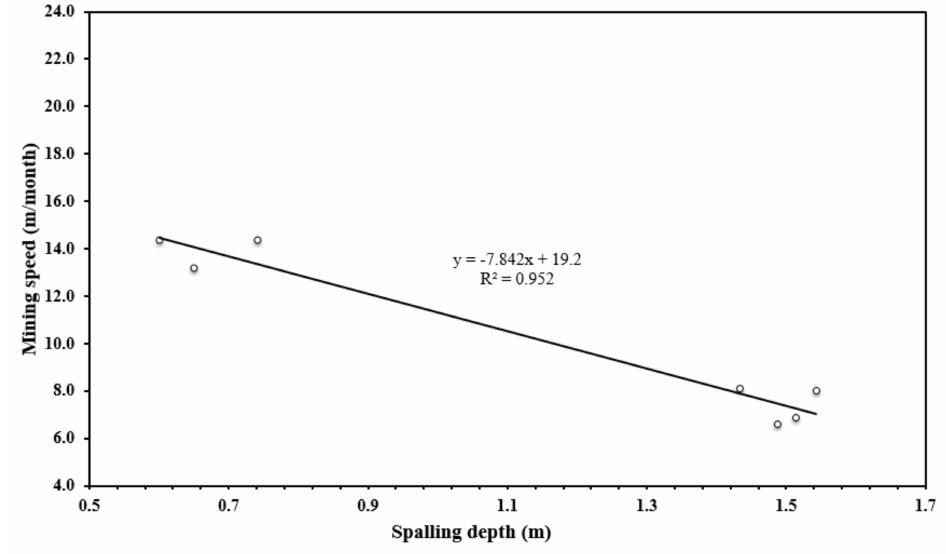
Figure 12. Relationship between the mining speed and spalling